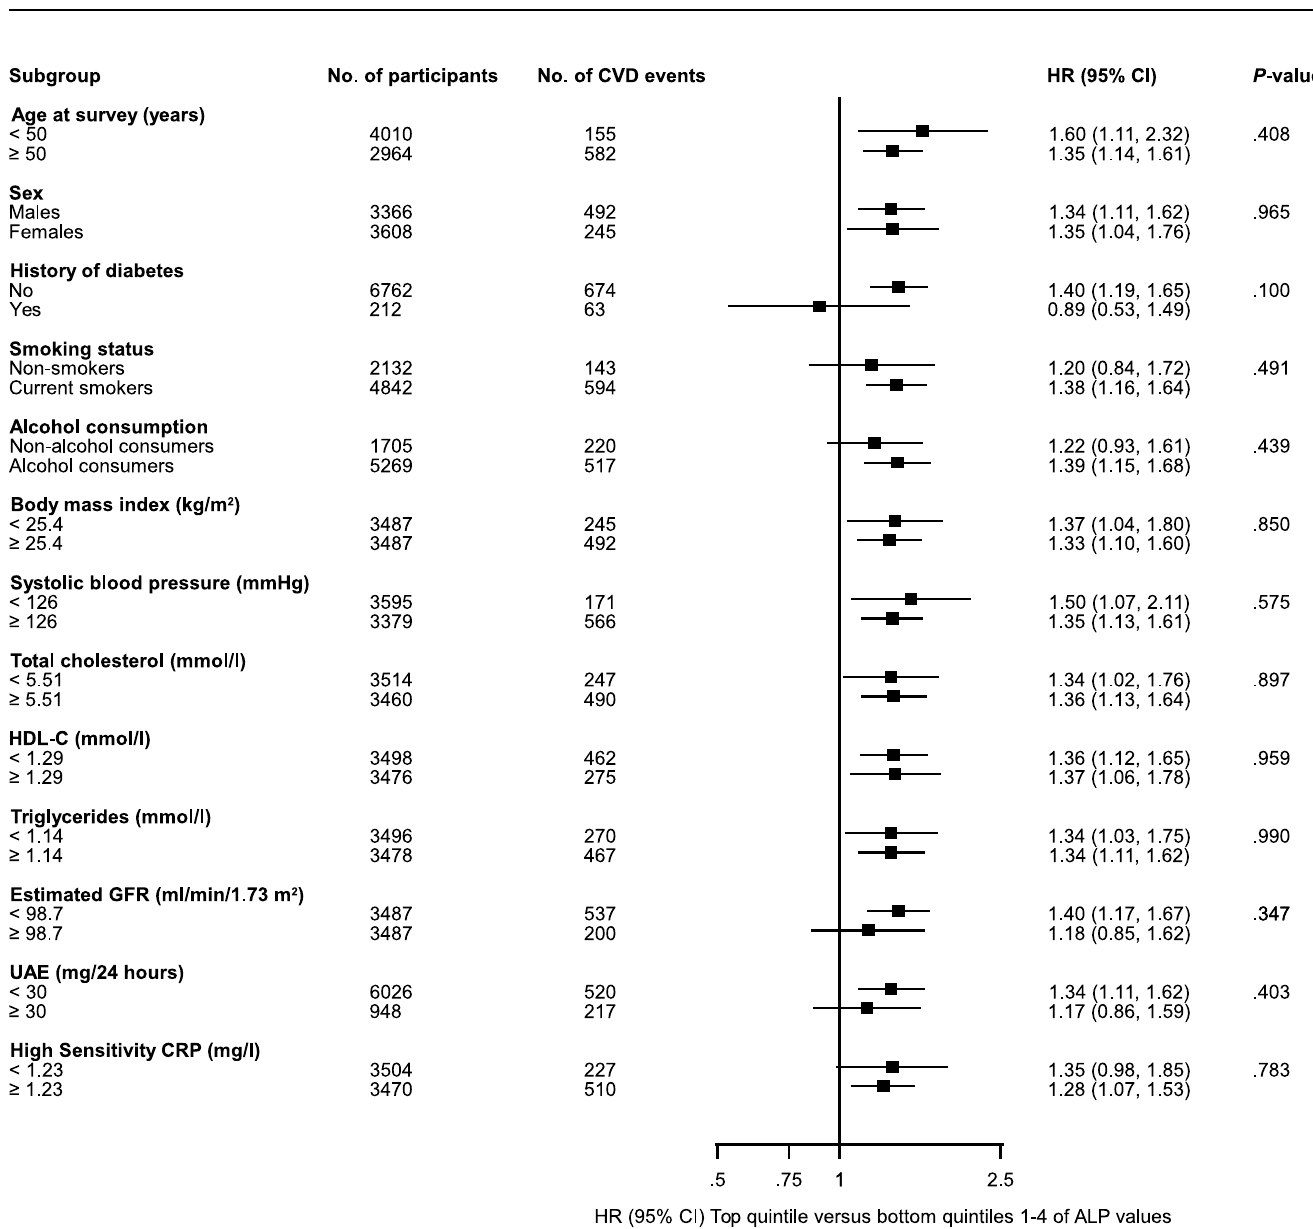
Fig 2. Hazard ratios for cardiovascular disease comparing top quintile versus bottom quintiles 1 – 4 of baseline ALP values, by several participant level characteristics. Hazard ratios were adjusted for age, sex, smoking status, history of diabetes, systolic blood pressure, total cholesterol, and high- density lipoprotein cholesterol (HDL-C); CI, confidence interval (bars); CRP, C-reactive protein; CVD, cardiovascular disease; Estimated GFR, glomerular filtration rate (as calculated using the Chronic Kidney Disease Epidemiology Collaboration combined creatinine-cystatin C equation); HR, hazard ratio; UAE, urinary albumin excretion; * , P -value for interaction; Cut-offs used for body mass index, total cholesterol, HDL-C, triglycerides, estimated GFR, and high sensitivity CRP are median values.